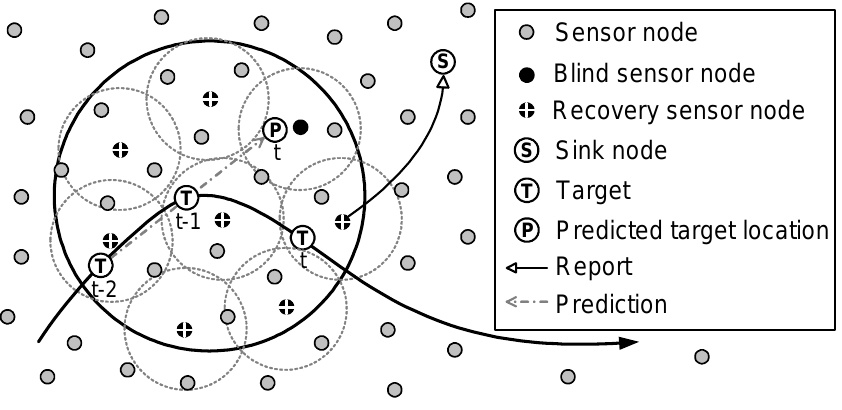
Sensor node Blind sensor node sensor